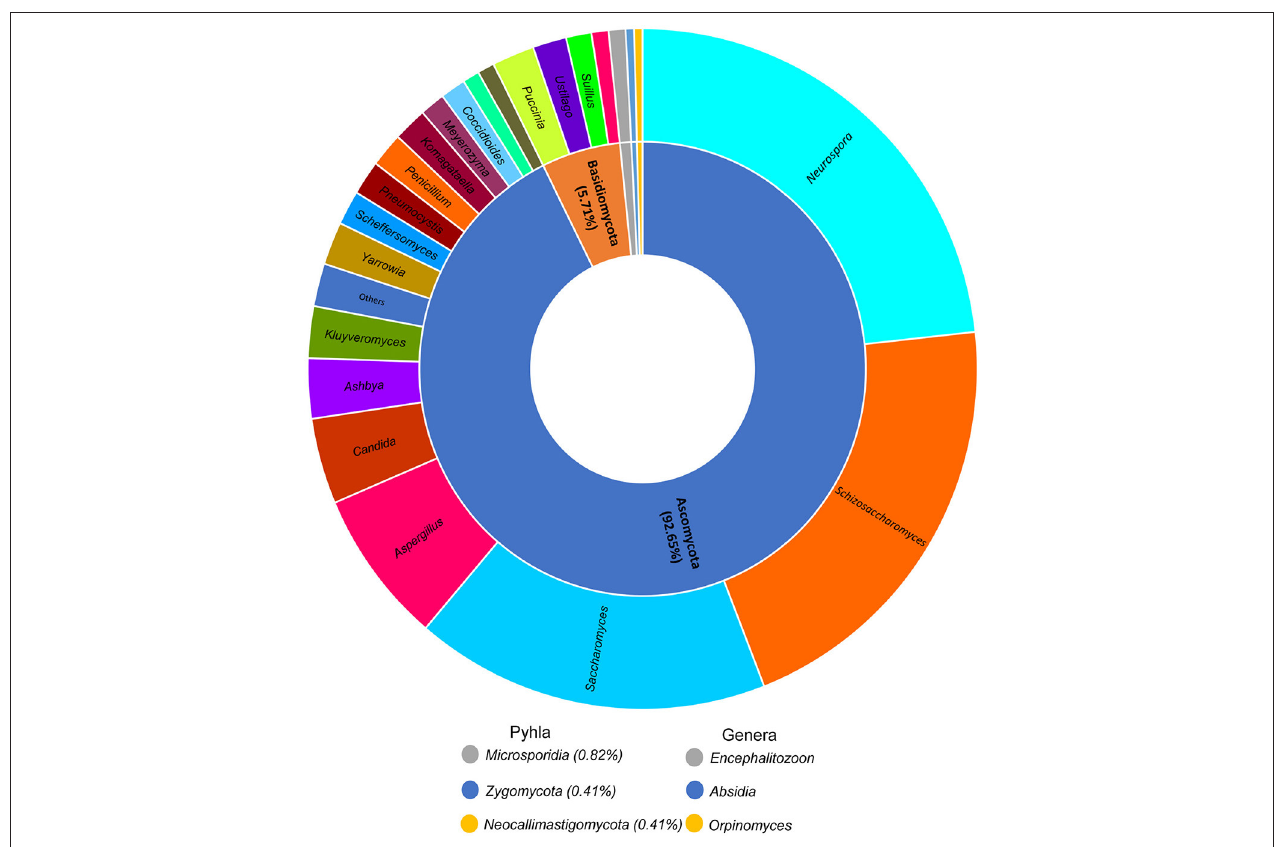
FIGURE 3 | Donut plots representing the fungi population in all pozol fermentation process. The inner and outer circles show the percentage distribution of the proteins at phylum and genus level, respectively.